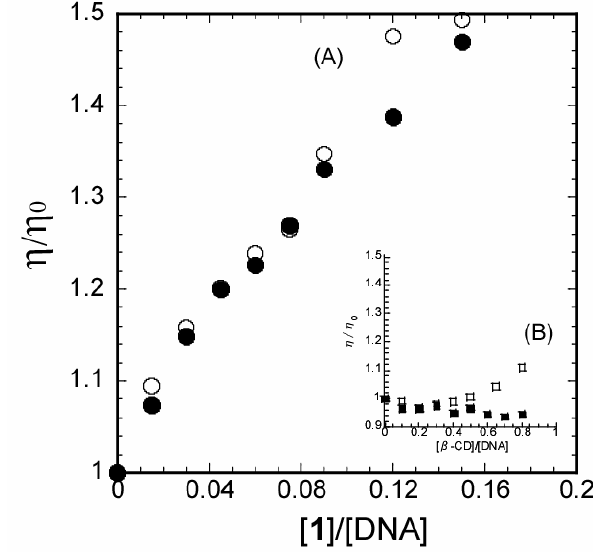
Figure 7. (A) Viscometric titration of 50 µ M sonicated calf thymus DNA with a various amount of 1 in the absence ( ● ) or presence of 80 µ M β -CD ( ○ ) at 20 ° C and (B) plot of viscosity change against [ β -CD]/[DNA] for 50 µ M sonicated calf thymus DNA unbound ( ■ ) or bound to 5 µ M 1 ( □